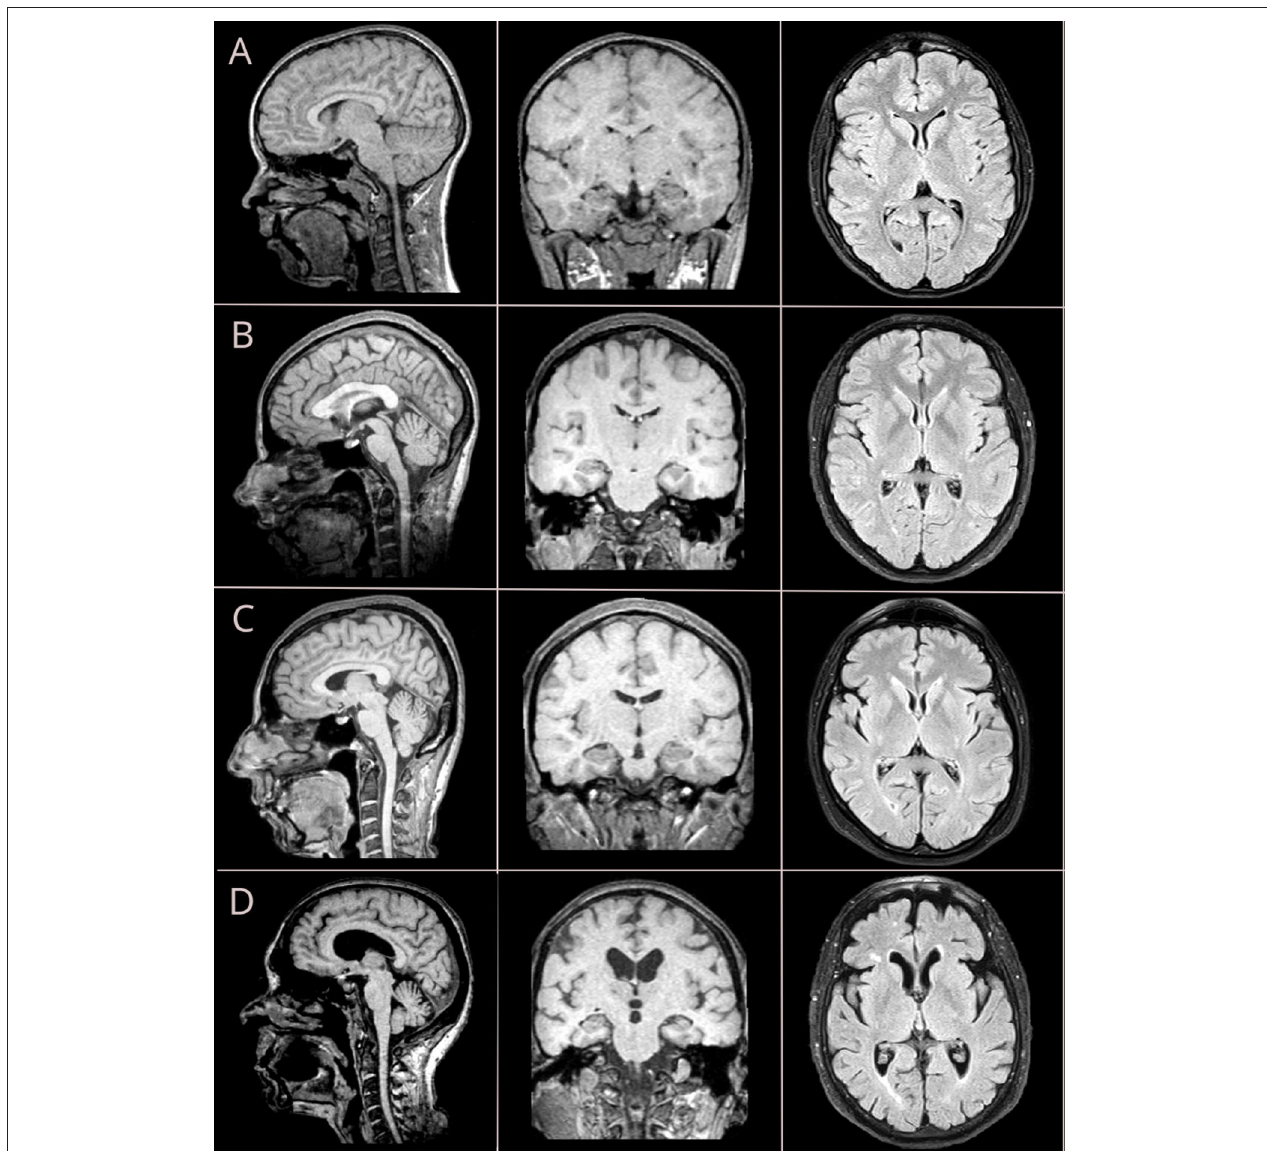
FIGURE 1 | Brain MRI changes across four life periods: adolescent age (A) , young adulthood (B) , midlife age (C) , and older adulthood (D) . Sagittal and coronal views are reconstructed from T1-weighted (T1W) sequence with isometric (3D) vowel; axial views are retrieved from fluid-attenuated inversion recovery (FLAIR)